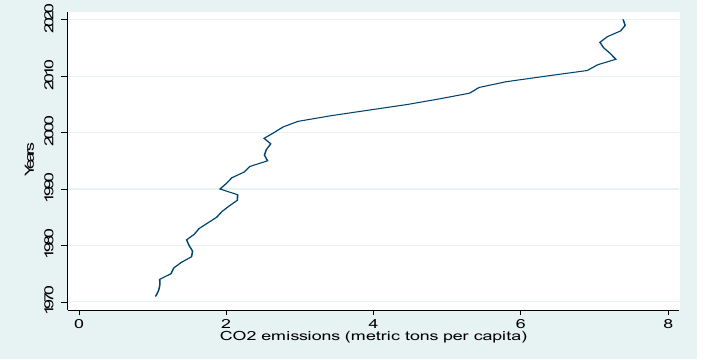
Figure 3. The GDP per capita trend for the economy of China for the period 1971–2020.